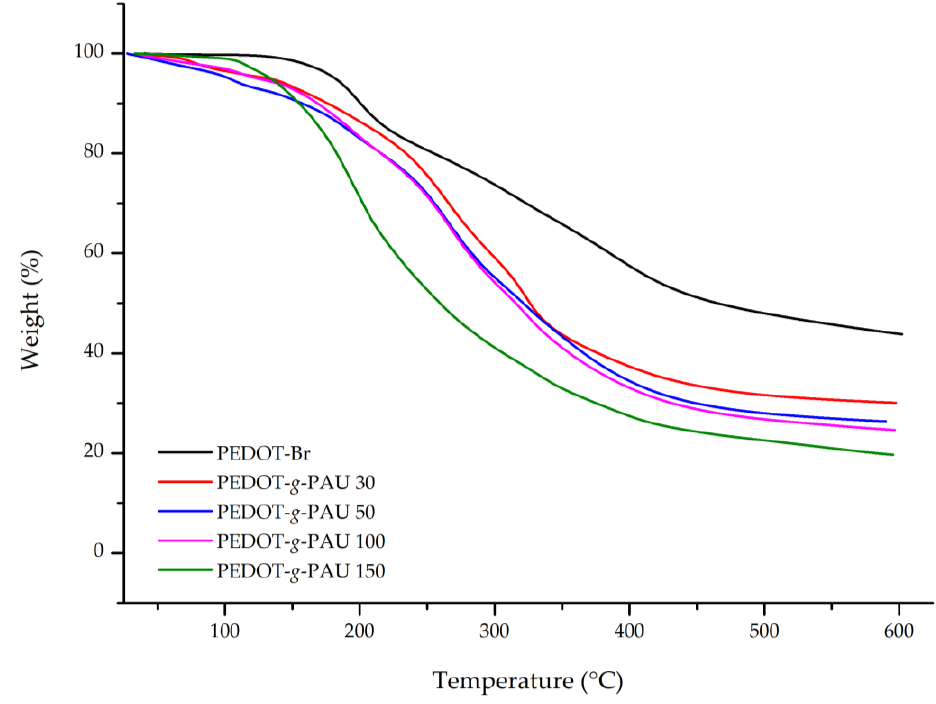
Table 3. Thermal properties of PEDOT-Br macroinitiators and copolymers PEDOT- g -PAU.